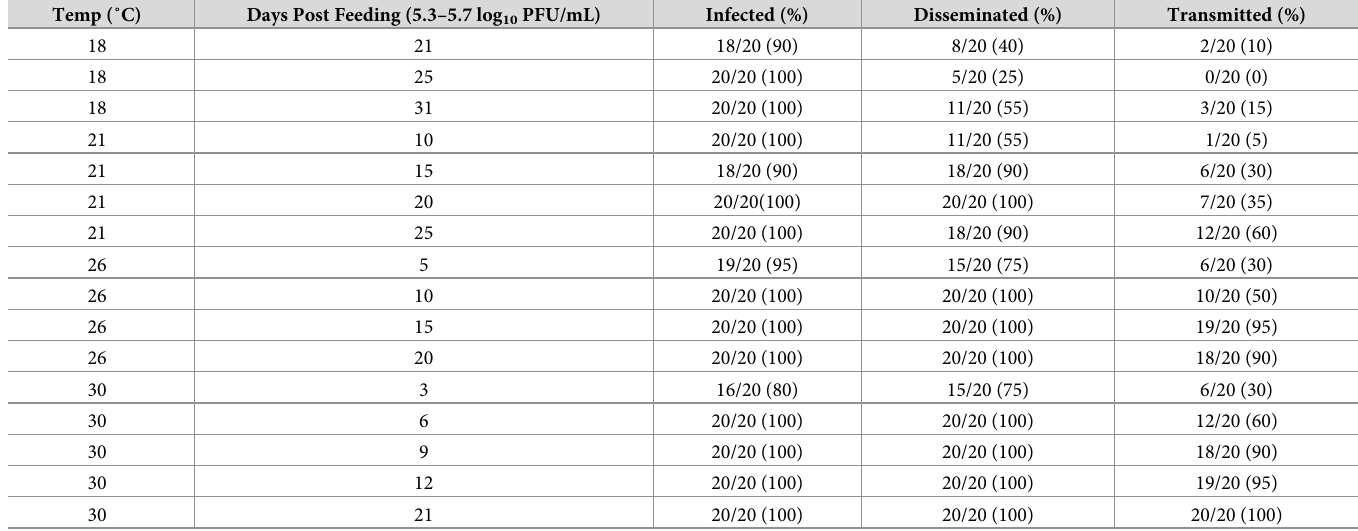
Table 1. ZIKV vRNA infection, dissemination, and transmission rates by temperature and time point. Samples were processed in duplicate by RT-qPCR. Ct values < 38 in at least one of the duplicates indicated positive vRNA. Temp